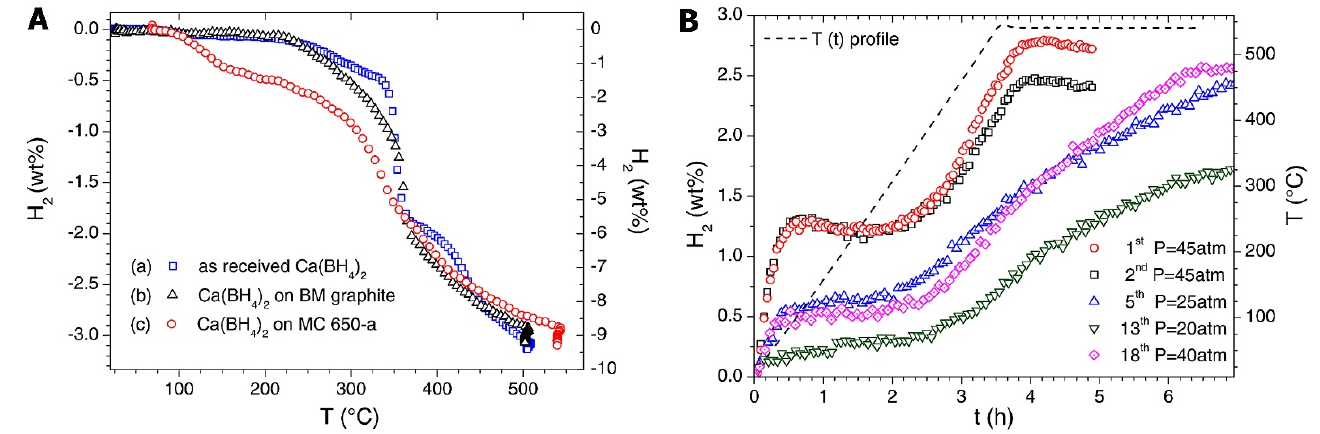
Figure 18. ( A ) TPD curves of Ca(BH 4 ) 2 with a heating rate of 2.5 °C min − 1 . Use vertical scale on the right for (a) as-received material; use scale on the left for Ca(BH 4 ) 2 on ball-milled graphite (b) and on MC 650-a (c). ( B ) TPA curves of nanocomposite Ca(BH 4 ) 2 @MC 650-a for successive hydrogenation cycles at different pressures. Reprinted with permission from Ref. [260].